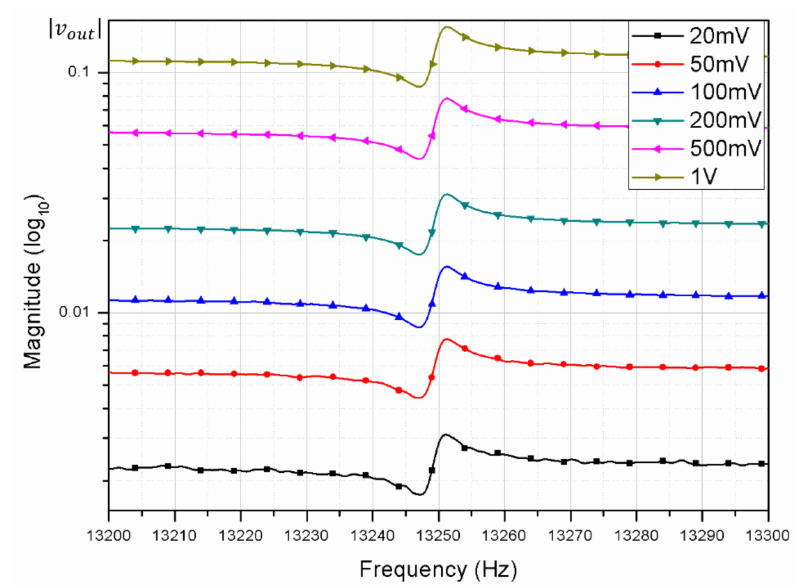
Figure 5. Frequency response of a resonator from increasing the AC voltage at a fixed DC voltage of 1 V.